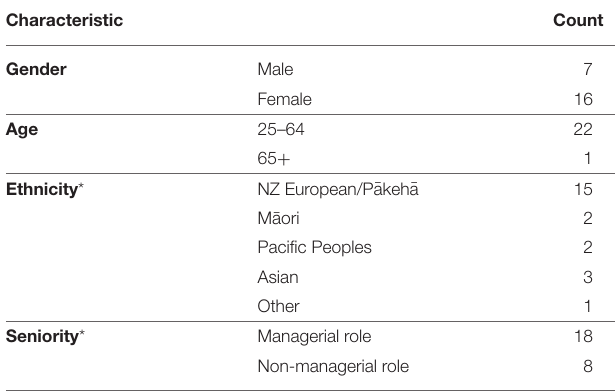
TABLE 2 | Qualitative participants characteristics ( N =